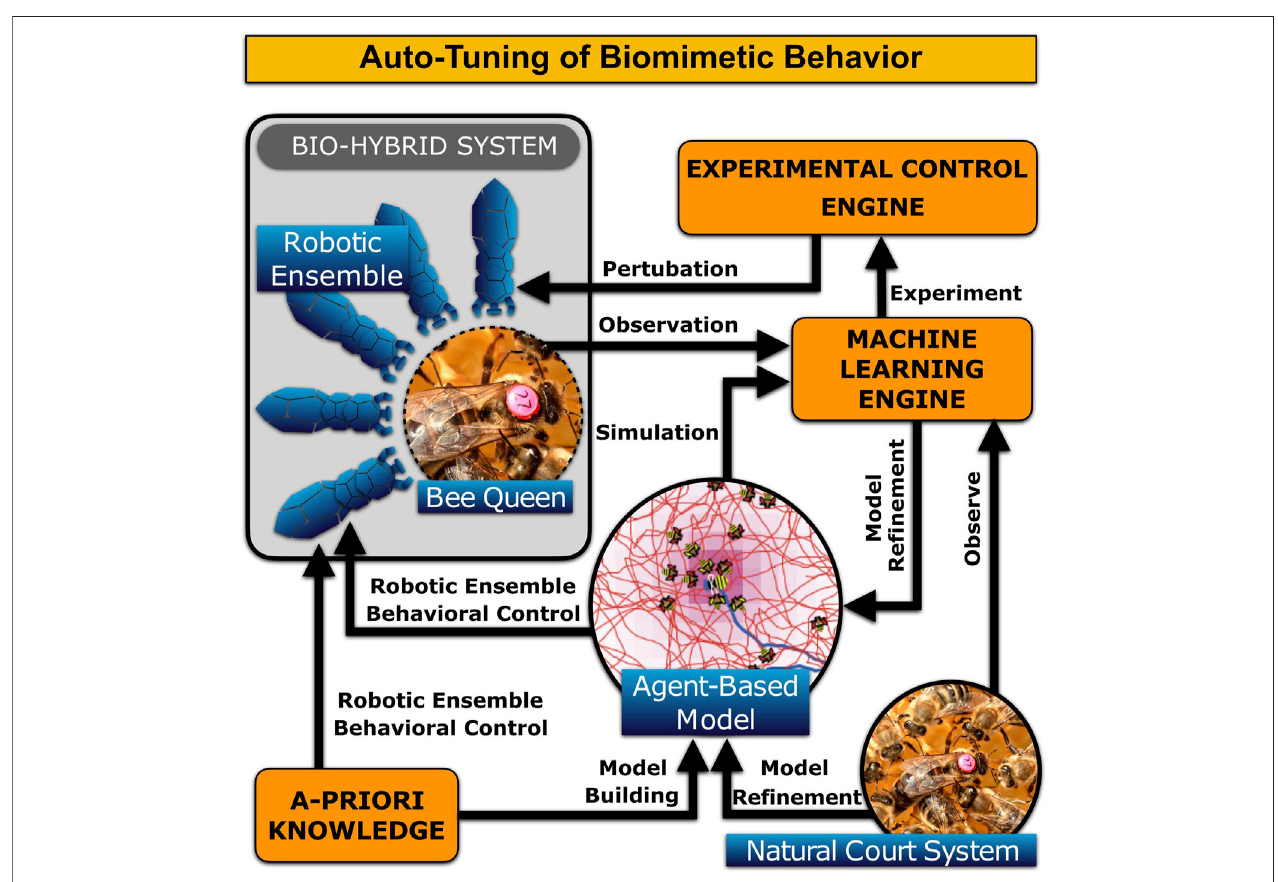
FIGURE12| Overallconceptofhowtheagent-basedmodelofthequeencourtbehaviorcanbedistilledandre fi ned via MachineLearningincombinationwithaset of auto-generated perturbation experiments.